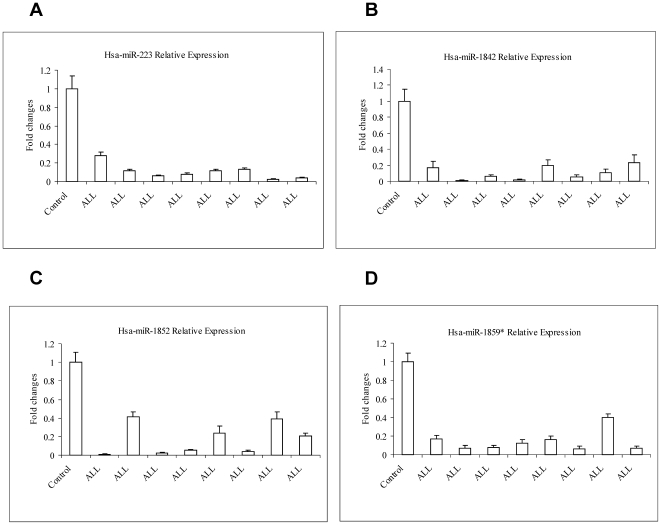
The expressions of four miRNA were validated in the patient group compared with the control group using qRT-PCR.